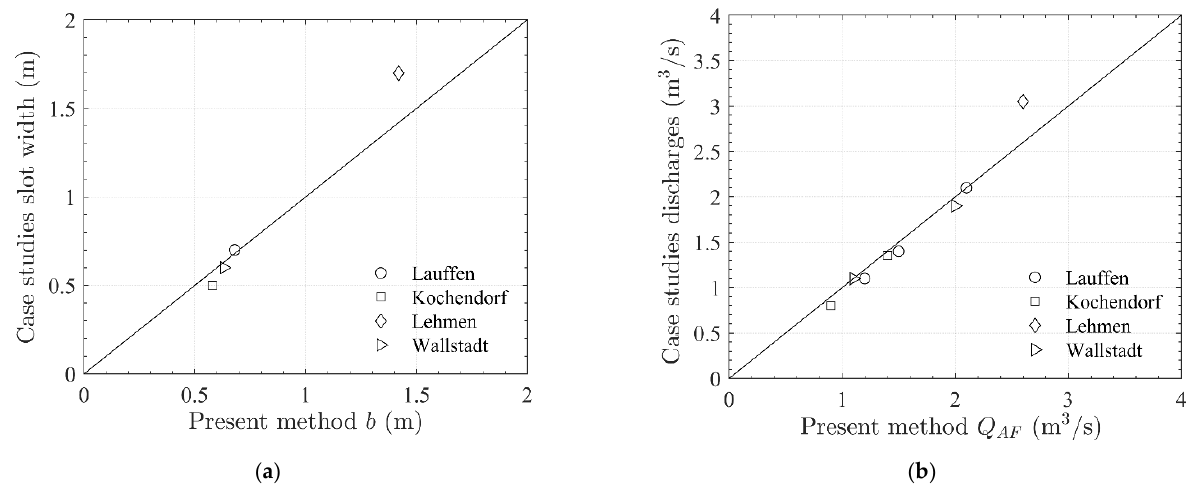
Figure 9. Comparison of the results of the present methods and case study results for ( a ) slot width 𝑏 and ( b ) attraction discharge 𝑄 (cid:3002)(cid:3007) . Where available discharges are compared for three different hydraulic conditions as given in Table 3.